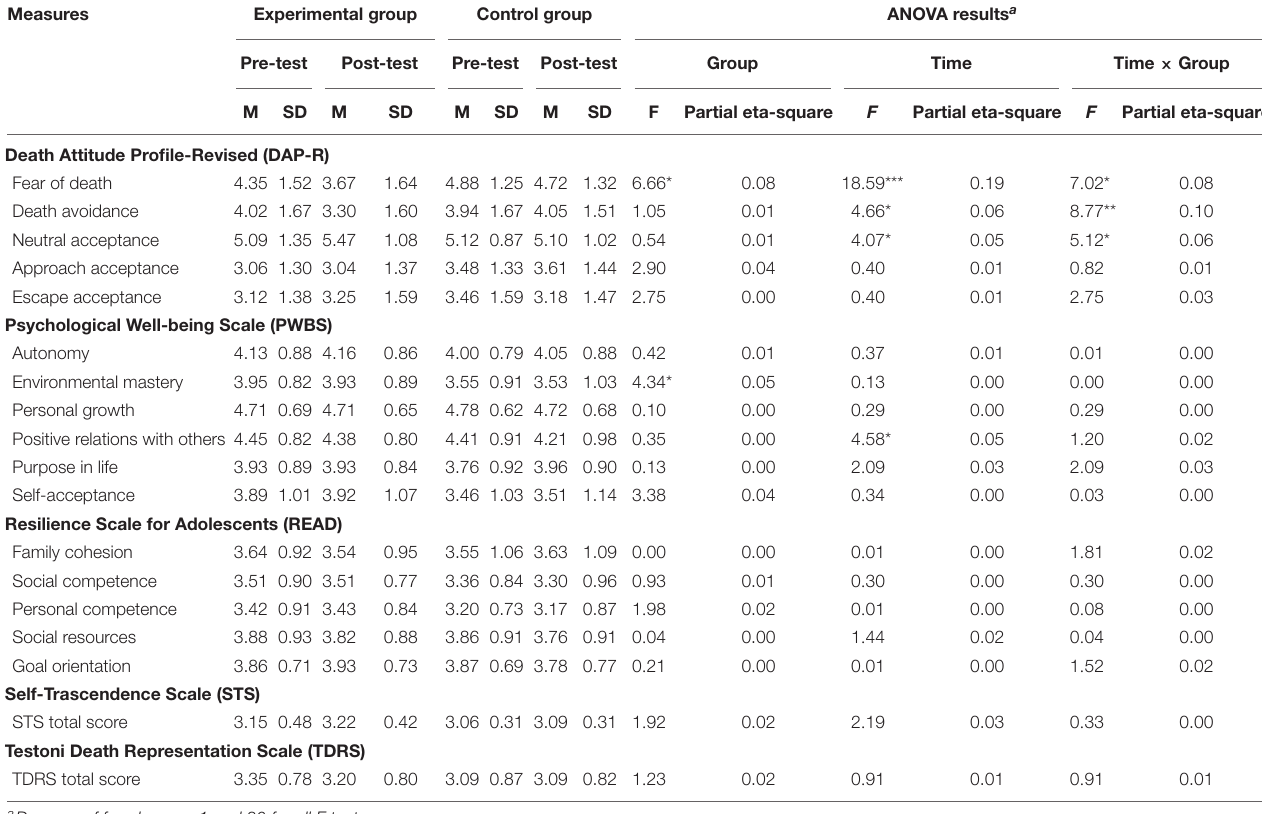
TABLE 2 | Descriptive statistics of all study variables by time for each group with ANOVA results.